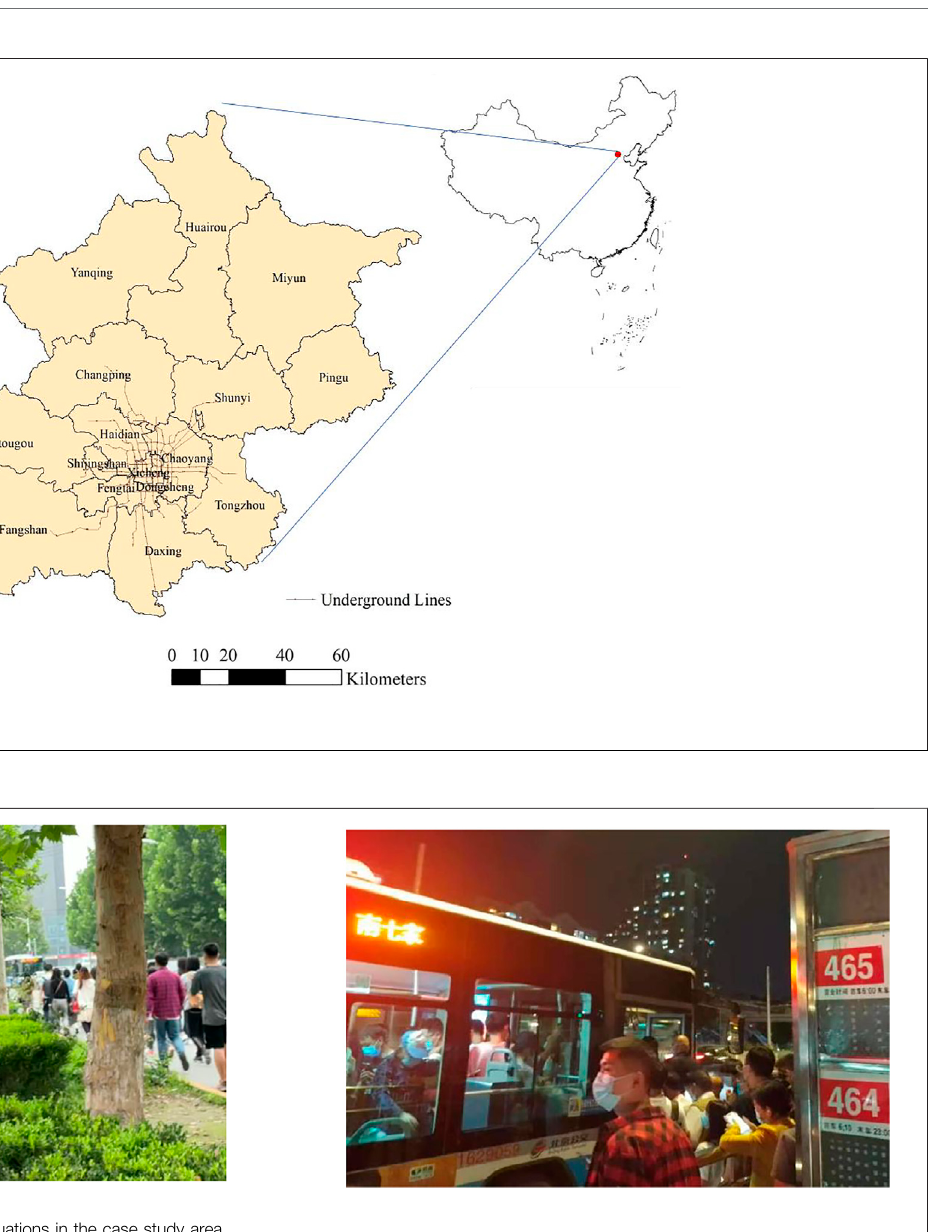
FIGURE 2 | Long-distance commuting situations in the case study